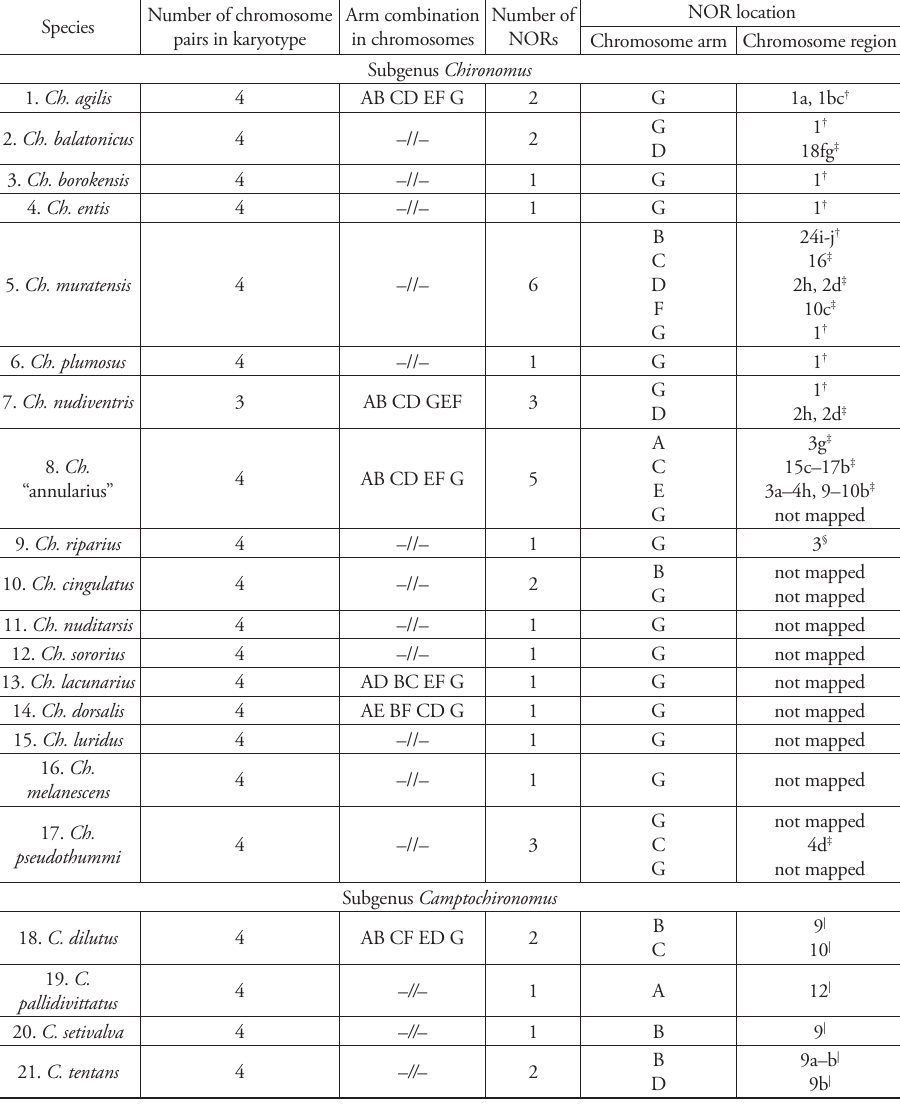
Table 3. The number of chromosome pairs in karyotype, combinations of arms in chromosomes, and number and locations of nucleolus organizer regions (NORs) in Chironomus